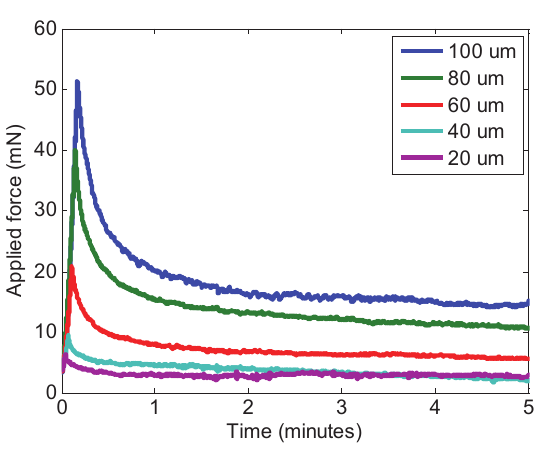
Fig. 10: Measured relative permittivity of acellular alginate during small strain indentation experiments calculated from eq. 33. Legend denotes final indentation depth.